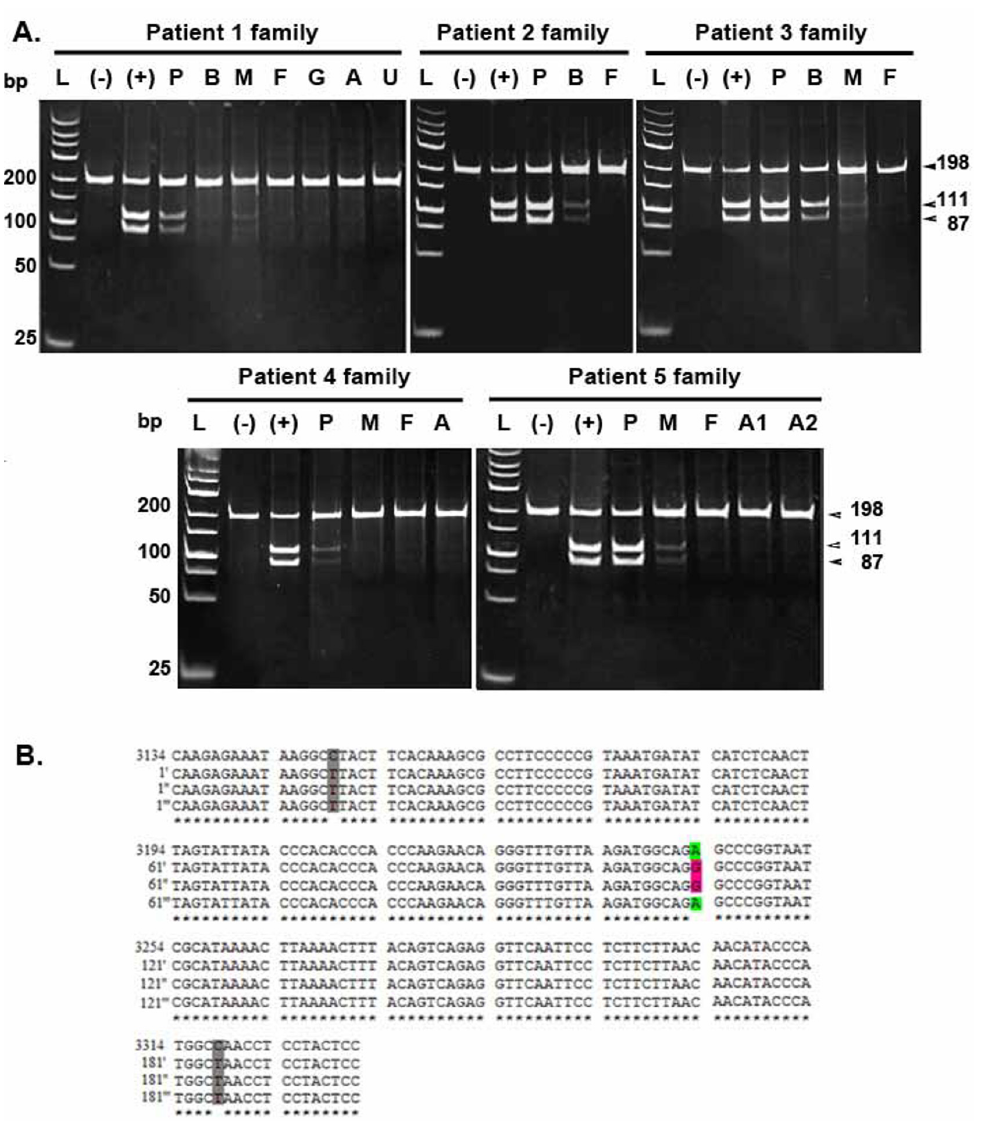
Figure 1. Detection of A3243G mutation in five family members of encephalomyopathy patients using PCR-RFLP. (A) Polyacrylamide gel electrophoresis of PCR-RFLP (Hae III digestion) products. L: Low range DNA ladder; (-): negative control (PCR product without Hae III digestion); (+): positive control (PCR product having Hae III digestion); P: patient; M: mother; F: father; B: brother; G: grand mother; A: aunt; A1: aunt 1; A2: aunt 2; U: uncle. (B) Comparison of mitochondrial 3134-3331 nucleotide sequence of family member 2 with the reference sequence (J01415.2) in the GenBank. 1’: sequence of patient; 1”: sequence of mother; 1’”: sequence of